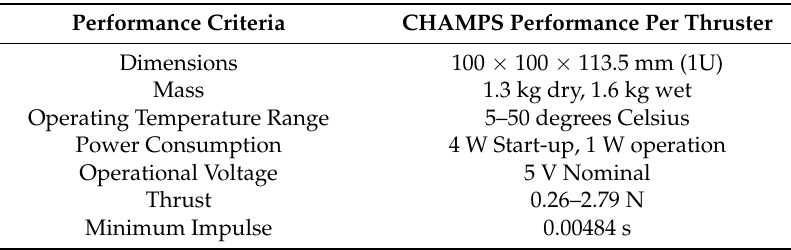
Table 6. CHAMPS Performance Specification.